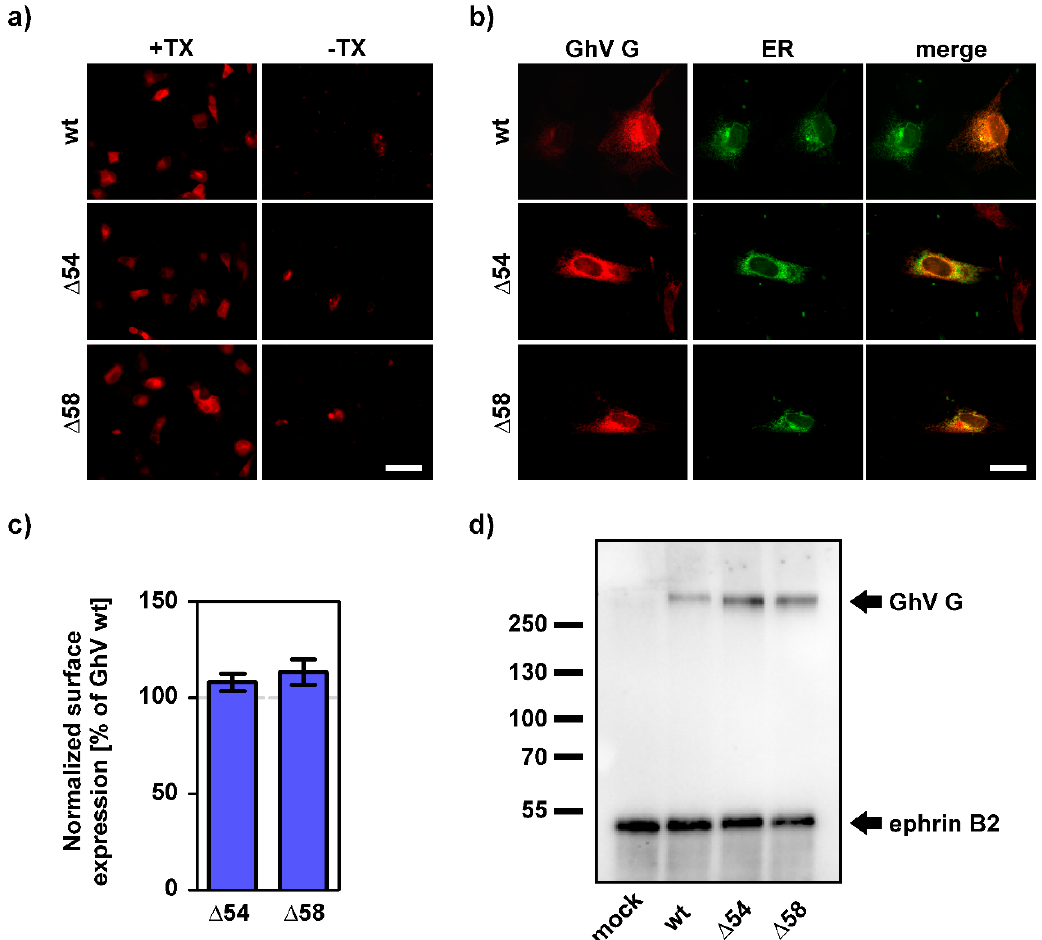
Figure 3. Truncation of the CD of GhV G does not a ff ect the cellular expression pattern. ( a ) Fruit bat (EidNi / 41) cells were transfected for the expression of wildtype or truncated GhV G proteins. At 24 h p.t., cells were either permeabilized ( + TX) or non-permeabilized (-TX) to visualize total or only surface expressed proteins, respectively. Scale bar indicates 50 µ m. ( b ) Fruit bat (HypNi / 1.1) cells were cotransfected for the expression of GhV G proteins and a cellular compartment marker for the endoplasmic reticulum (ER). Red: G proteins, green: ER. Scale bar indicates 20 µ m. ( c ) Surface expression of truncated GhV G proteins was quantified by flow cytometry and the mean fluorescence intensity obtained for GhV G ∆ 54 and ∆ 58 was normalized to that of wildtype GhV G, which was set as 100%. The graph shows mean and SEM of three independent trials. Statistical significance was tested by paired, two-tailed Student’s t-tests with 95% confidence intervals (no significant di ff erences were obtained: p > 0.05). ( d ) Cell lysates of G expressing cells were loaded onto protein-A sepharose beads mixed with Fc-conjugated mouse ephrin-B2. After immunoprecipitation, SDS-PAGE and Western blotting were performed. Proteins were visualized by incubation with anti-Flag antibodies (mouse) and anti-mouse IgG horseradish peroxidase (HRP). Numbers on the left indicate molecular weight (kDa). Exposure time: 45